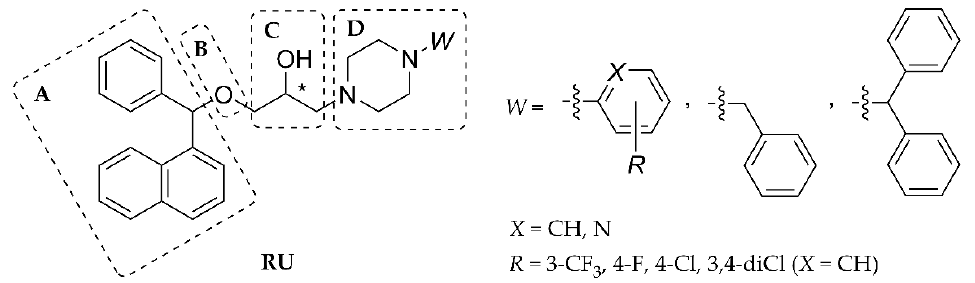
Figure 1. General structure of naphthalene-based RU derivatives investigated in vitro as well as in silico against Mycobacterium tuberculosis H 37 R v . (* = chiral center)